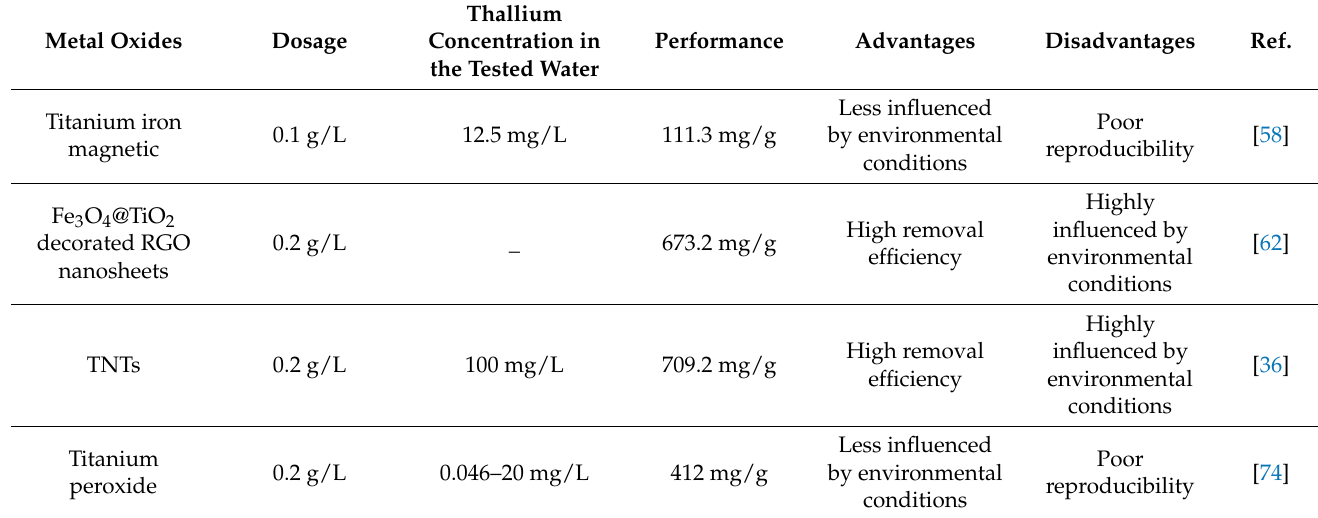
Table 4. Titanium oxide removal thallium performance and its advantages and